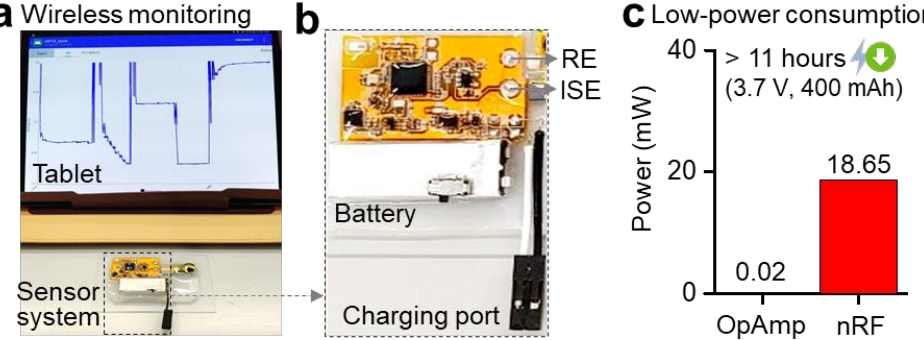
Figure 3. Wireless, low-power sensor system. ( a ) Photo of a wireless sensor system and a portable tablet, using Bluetooth for data acquisition. The tablet shows real-time voltage changes from sodium ions, measured by the sensor system. ( b ) An enlarged photo showing the sensor system, including multiple chip components on a flexible circuit, sensor connection pads for RE and ISE, and a rechargeable battery with a switch. ( c ) Power consumption measured by two main chips (OpAmp and nRF microcontroller) for wireless voltage monitoring. The device operation time with continuous detection of sodium ions is over 11 h with a rechargeable battery.